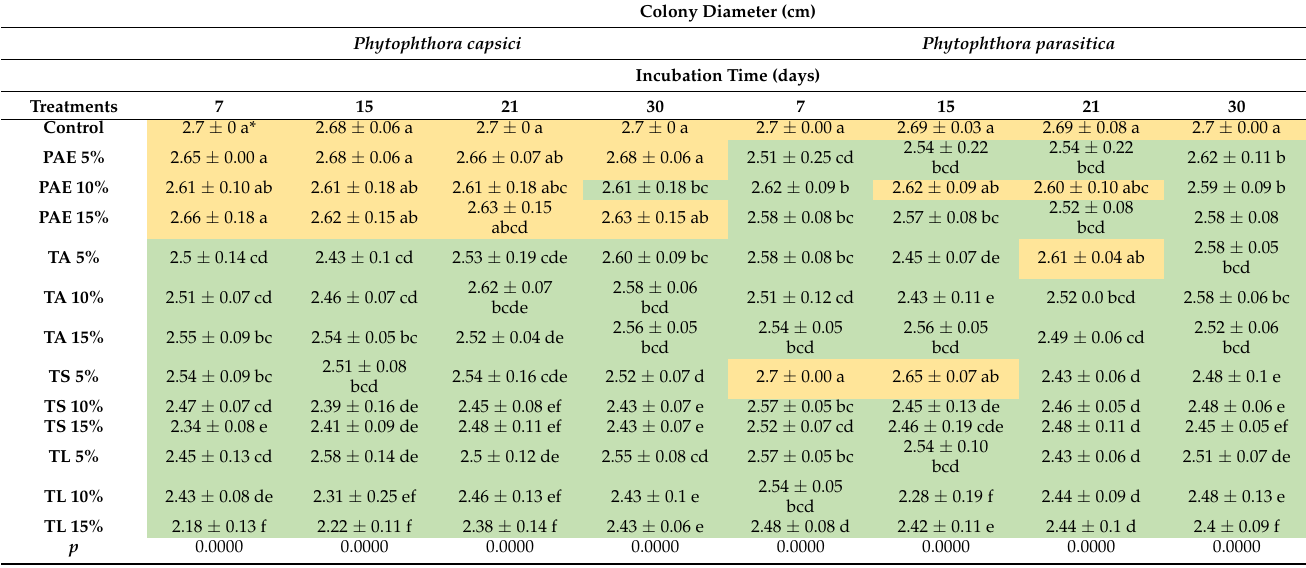
Table 2. Mycelial growth of P. parasitica and P. capsici in PDA medium supplemented with 5, 10, and 15% microfiltered extract of TA, TL, TS, and PAE at different incubation times (7, 15, 21 and 30 days) in the dark and at 25 ◦ C.